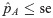
Relationships between reported and revised cases of disease A under different misdiagnosis scenarios with disease B.Sensitivity and specificity values span 0.2, 0.5, 0.8, and 0.99 across rows and columns. Colors denote different values of observed cases of disease B. The gray line is the 1:1 line, which separates when revised cases of disease A are higher than reported (above) and when revised cases of disease A are lower than reported (below). Plots with no lines indicate that a constraint was broken (se+sp≠1 or p^A≤se). Lines only span portions of the x-axis under which revised cases of disease A is positive.